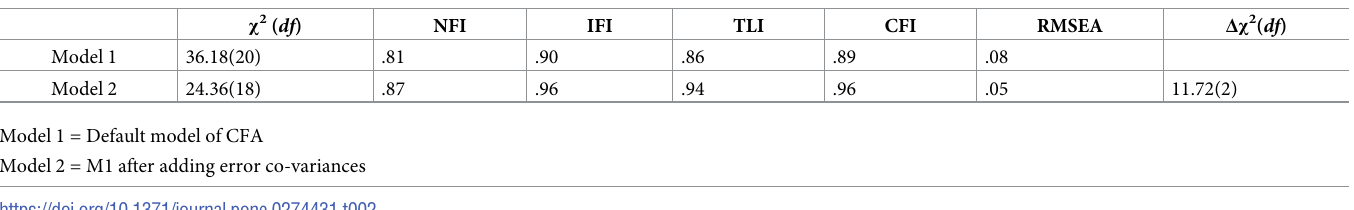
Table 2. Fit indices of confirmatory factor analysis for Executive Function Touch